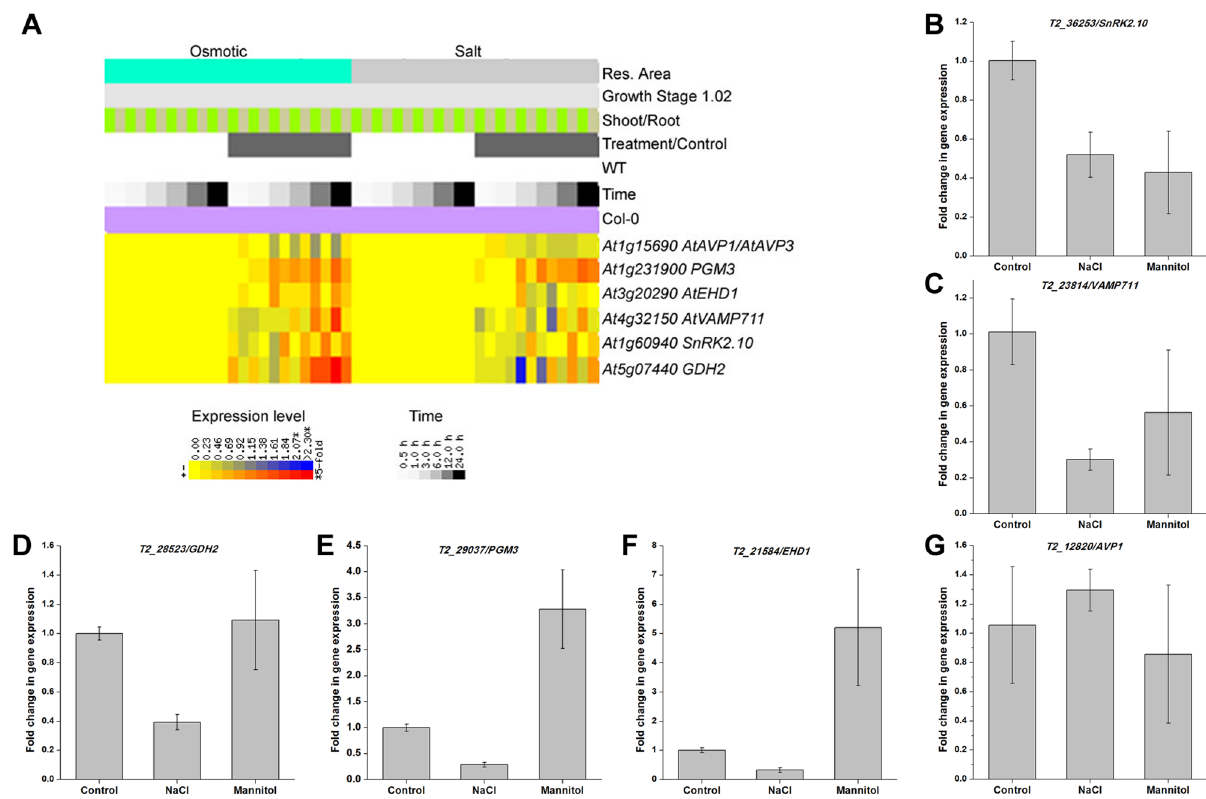
Fig 6. Expression patterns of the six core stress responsive genes in B . humilis . (A) Heatmap to show six Arabidopsis gene expressionprofiles under osmotic and salt stress treatments. This graphic was created using the BAR Expression Browser [31]. The expressionprofiles of these six genesin responseto other abiotic stresses are shown in Supplementary Fig 4. (B) The transcript levels of six core stress genes in B . humilis seedlings were determined after treatments with 150 mM NaCl and 300 mM mannitol.Error bars represent ±